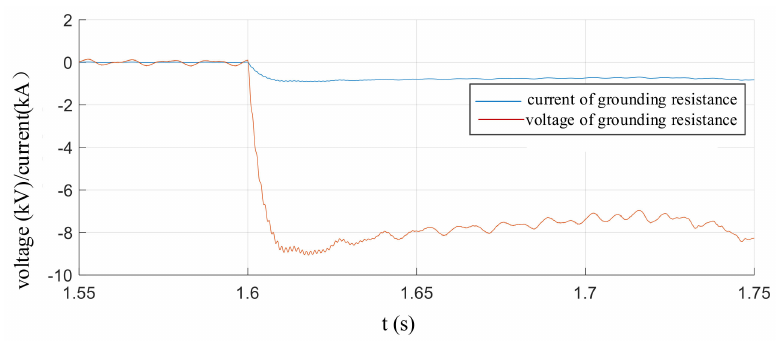
Figure 16. Voltage and current waveform of grounding